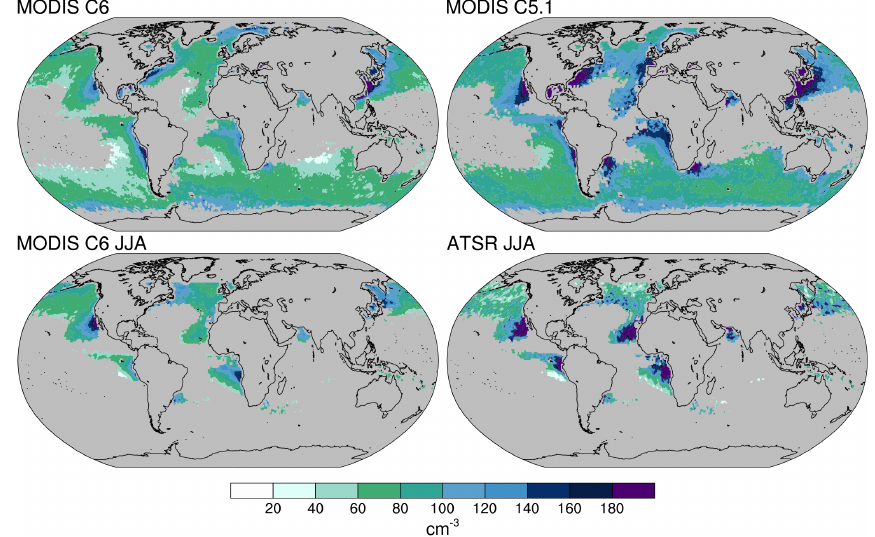
Figure 7. Annually averaged N from different satellite retrievals. Shown are MODIS collection 6 for 2008 (upper left) and MODIS collection 5.1 for 2007 (upper right); boreal summer (JJA) 2008 averages of MODIS collection 6 (lower left) and boreal summer (JJA) for AATSR- ORAC (lower right). Grey indicates no